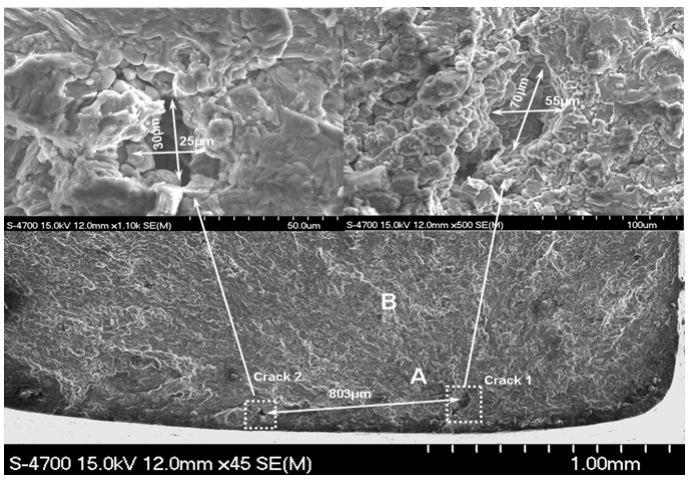
Figure 13. SEM image of a crack initiation site in specimen 8-26 (Fatigue life = 1,325,698 cycles)